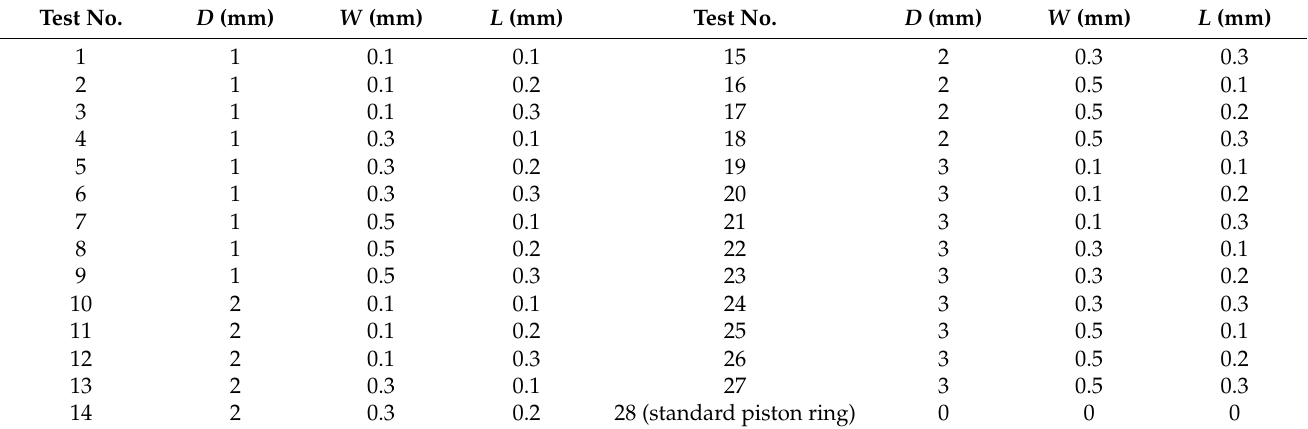
Table 2. Factor, level, and test